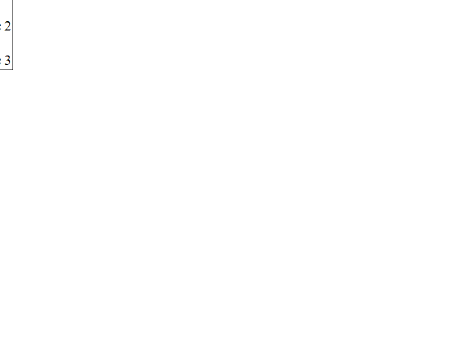
Figure 14. Comparison curve of horizontal displacement of end-suspended pile with H = 12.2 m.